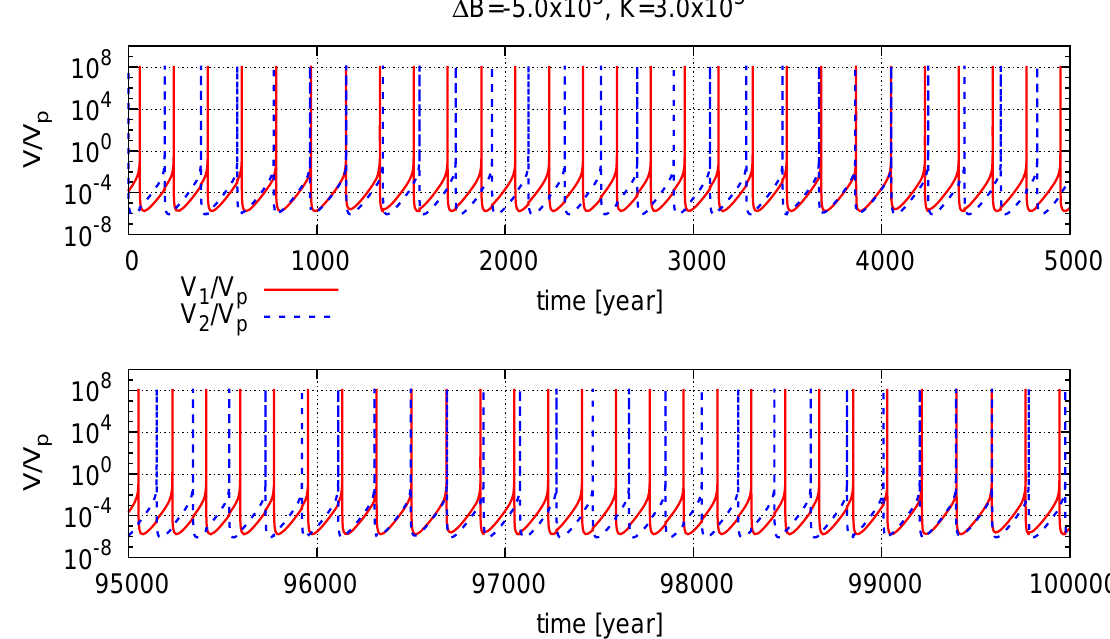
Fig. 8. The time evolution of V/V p for case 3 in a logarithmic scale. The variation from 5000 to 95000yr is not shown. The parameters are B = 2 . 20 × 10 5 Nm − 2 for oscillator 1, B = 2 . 25 × 10 5 Nm − 2 for oscillator 2, and K = 3 × 10 3 Nm − 3 . The oscillators are not